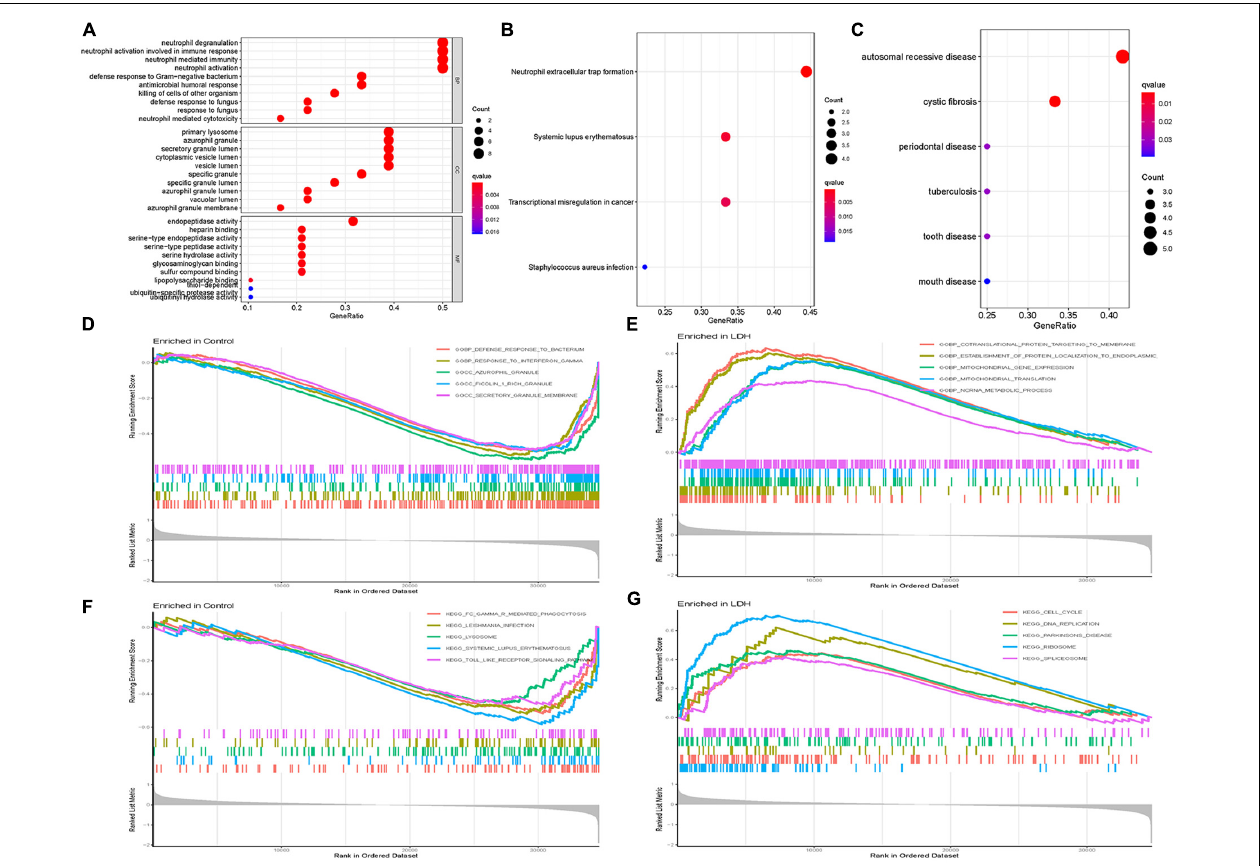
FIGURE 3 | Functional correlation analysis. (A) Gene Ontology (GO) enrichment analysis, where the circle size represents the count of DEGs (the larger the circle size, the more count of DEGs), and the color represents p -value (the redder the color, the smaller the value). GO analyses consisted of biological process (BP), molecular function (MF), and cellular component (CC). (B) Kyoto Encyclopedia of Genes and Genomes (KEGG) enrichment analysis, where the circle size represents the count of DEGs, and the color represents p -value. (C) Disease Ontology (DO) enrichment analysis, where the circle size represents the count of DEGs, and the color represents p -value. (D) Gene Set Enrichment Analysis (GSEA) in the normal group using annotation information of GO. (E) GSEA in the LDH group using annotation information of GO. (F) GSEA in the normal group using annotation information of KEGG. (G) GSEA in the LDH group using annotation information of KEGG [Net enrichment score (NES), gene ratio, and p -value in GSEA analysis were used to verify the GO and KEGG enrichment